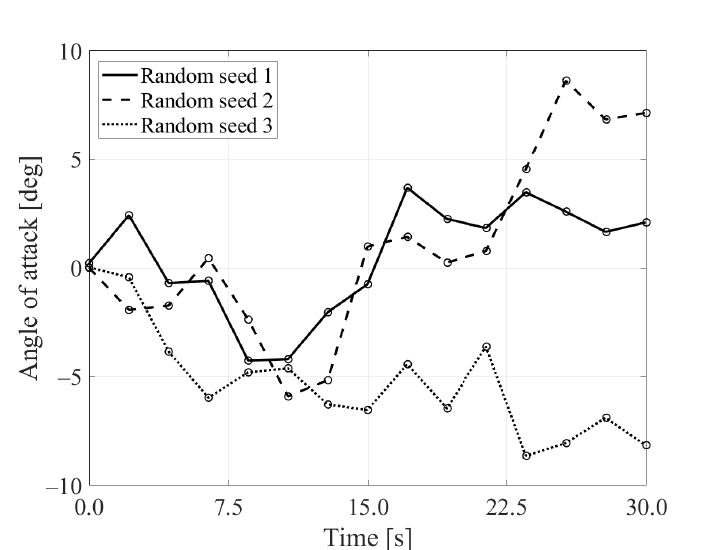
Figure 3. Neural network architecture.